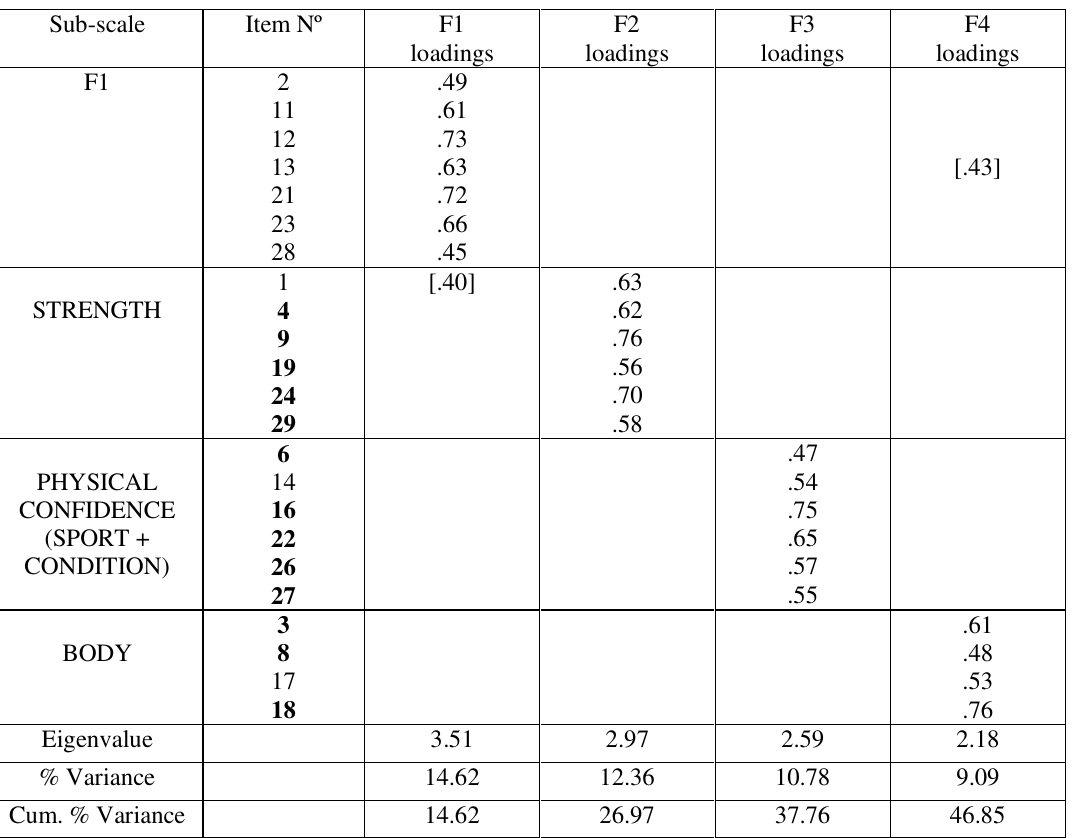
Principal components factor loadings for PSPP items – basketball players without